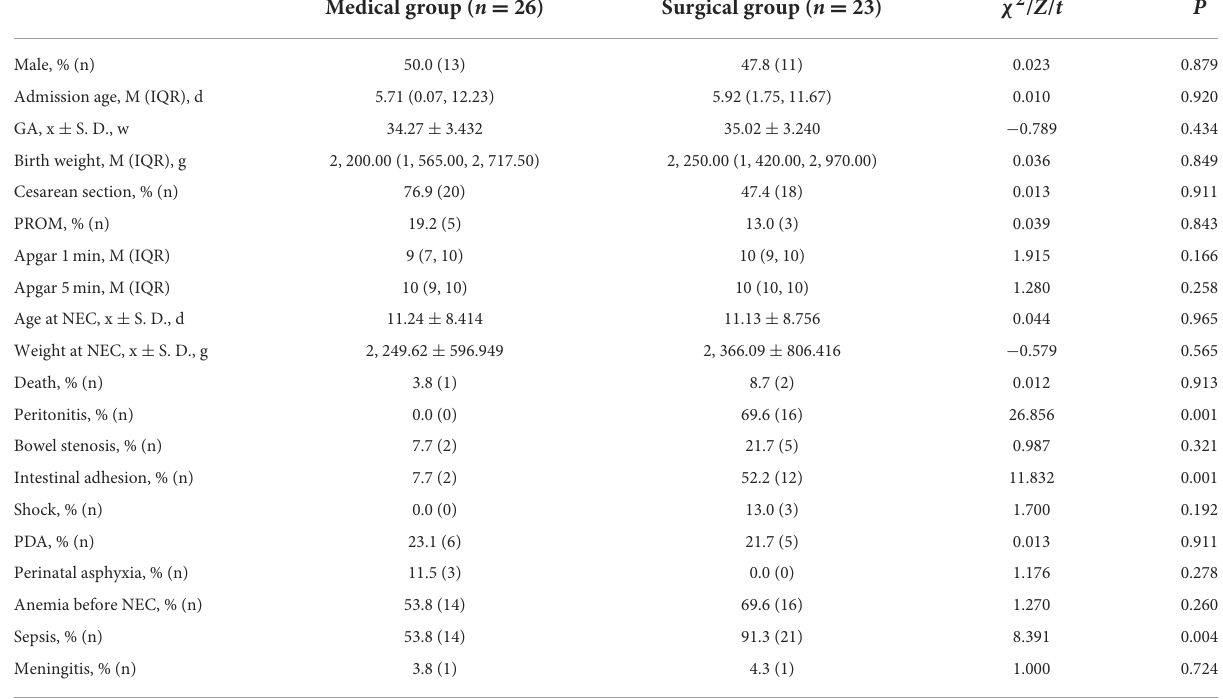
TABLE 1 Demographics of the infants enrolled in the study. Medical group ( n = 26) Surgical group ( n = 23)